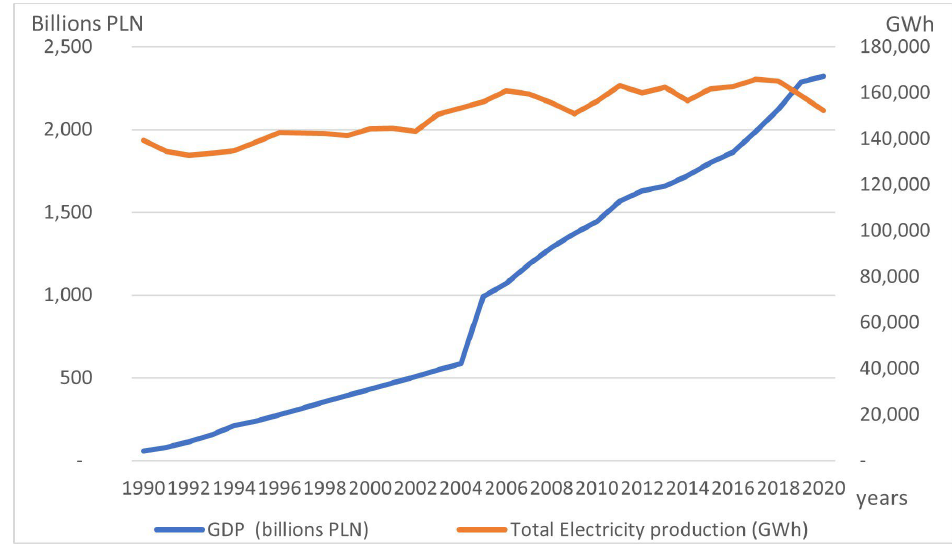
Figure 3. Energy production and GDP in Poland (1990–2020). Source: Energy. Statistical Yearbook, SP.